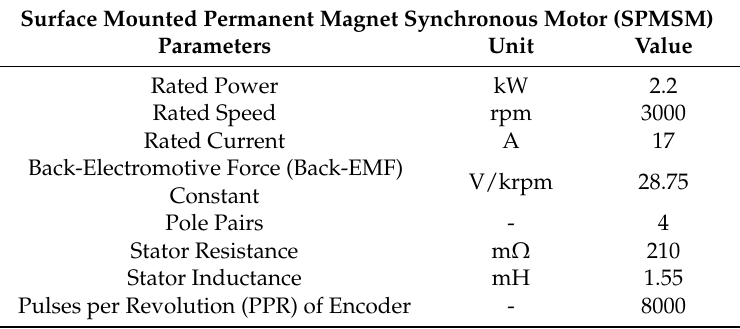
Figure 7. Back to back converter and motor-generator set for experimentation. Table 1. Motor specifications.